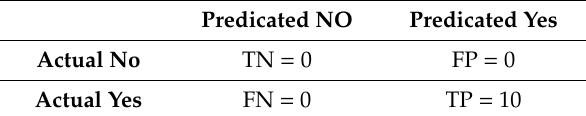
Table 8. Confusion matrix of fire class.